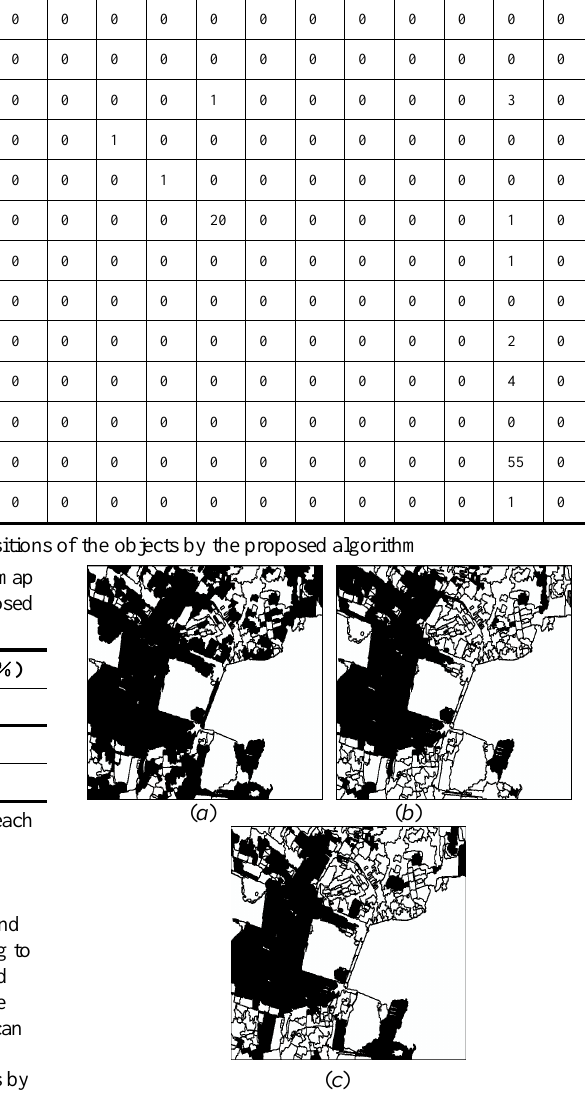
Figure 5 . Change detection results(black areas denote the changed areas): (a) PCC technique with 440 changed objects and 185 unchanged objects;(b) proposed method with 301 changed objects and 324 unchanged objects; and (c) ground truth with 316 changed objects and 309 unchanged objects.